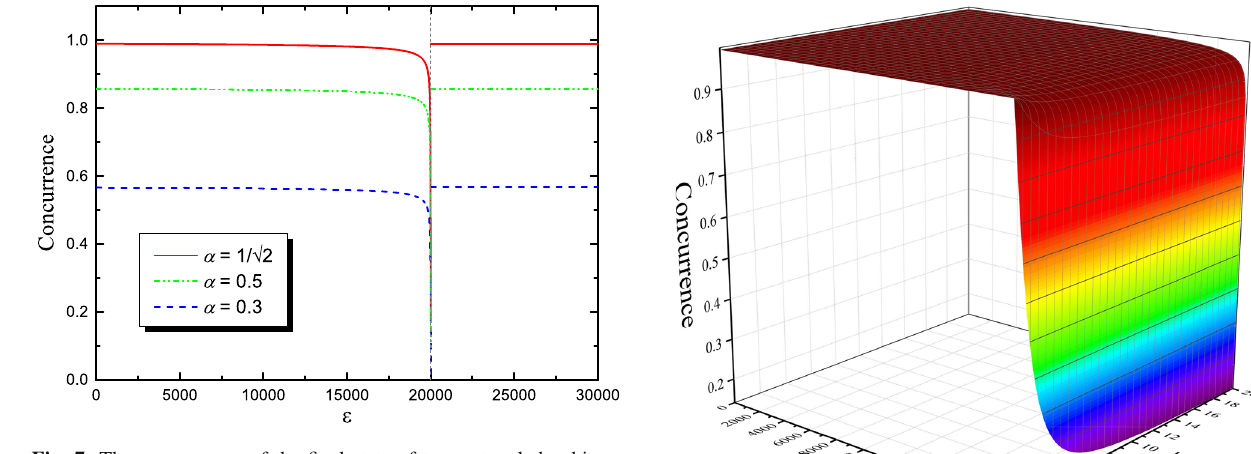
Fig. 7 The concurrence of the final state of two entangled qubits as a function of the volume ε of the cosmic expansion. The expansion rapidity is σ = 5. The parameters of the two qubits are the same. The qubit energy level difference is (cid:15) = 2, the inner product of the mode functions, defined in Eq. (21), is μ = 0 . 1, the mass of the scalar field particle is m = 0 . 01. The initial state of the qubits is α | 01 (cid:7) + β | 10 (cid:7)